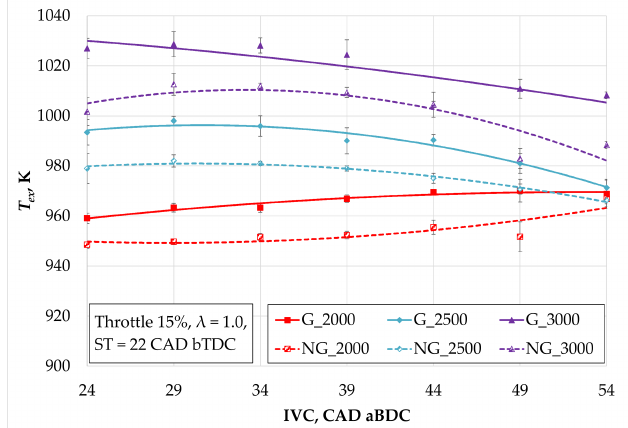
Figure 11. Exhaust temperature of the engine running on gasoline and natural gas and while changing the intake valve close